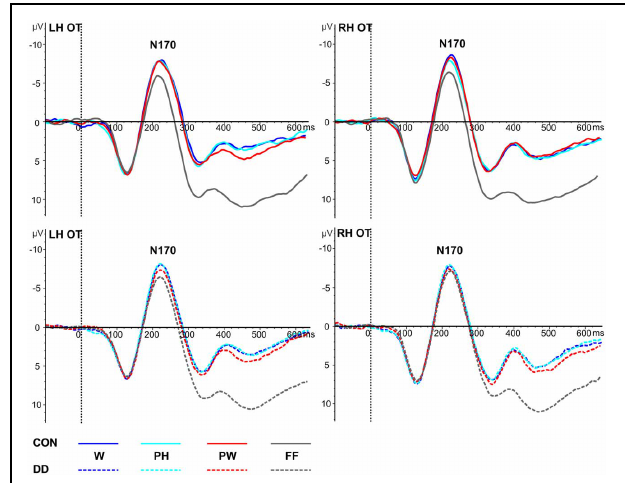
FIGURE 3 | Illustration of the averages across occipito-temporal (OT) electrodes included in the left hemispheric (LH) and right hemispheric (RH) ROIs of the N170 for control children (CON) and children with DD (DD). W, words; PH, pseudohomophones; PW, pseudowords; FF, false fonts. Negativity is depicted